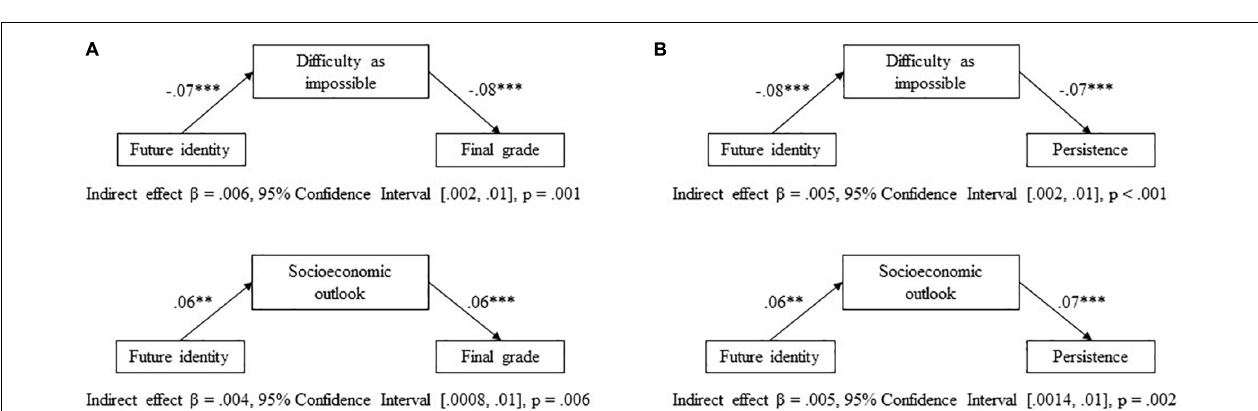
FIGURE 2 | Indirect effects of future identity treatment on final course grades (A) and persistence (B) through motivational processes in Study 2. ∗∗ p < 0.01, ∗∗∗ p <